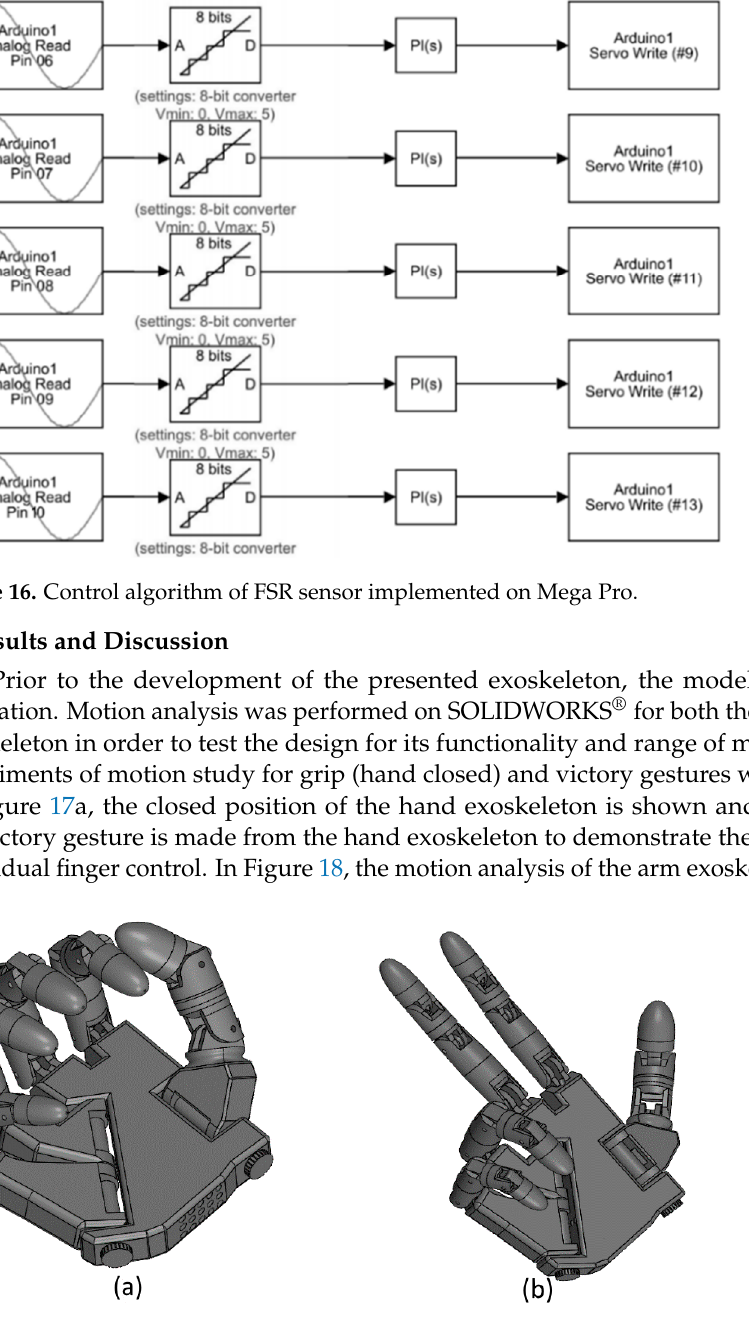
Figure 17. Motion analysis of the hand exoskeleton. ( a ) hand closed position, ( b ) semi hand-open position